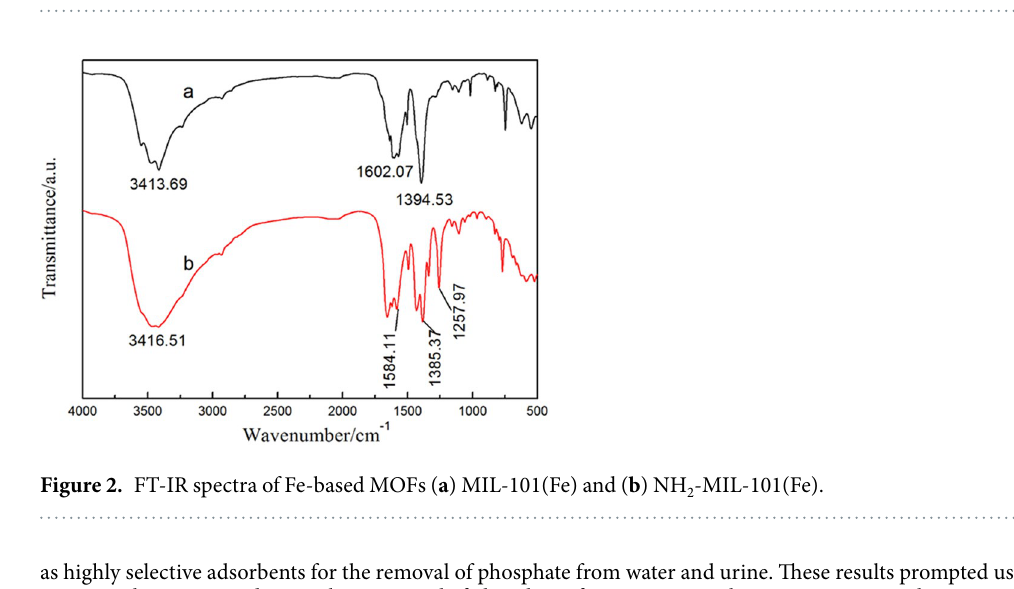
Figure 1. XRD patterns of Fe-based MOFs ( a ) MIL-101(Fe) and ( b ) NH 2 -MIL-101(Fe).